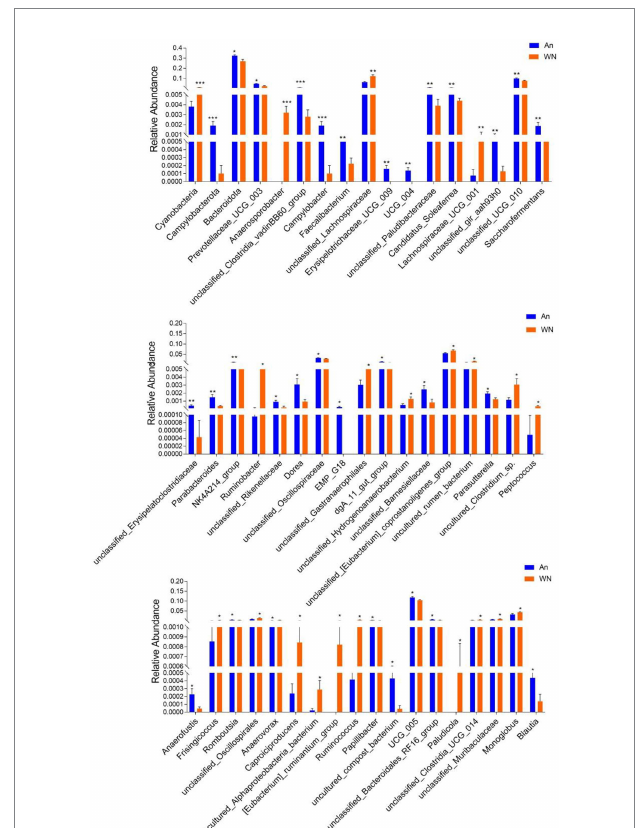
FIGURE 5 Statistical analysis of differential bacteria between An and WN groups at the phylum and genus